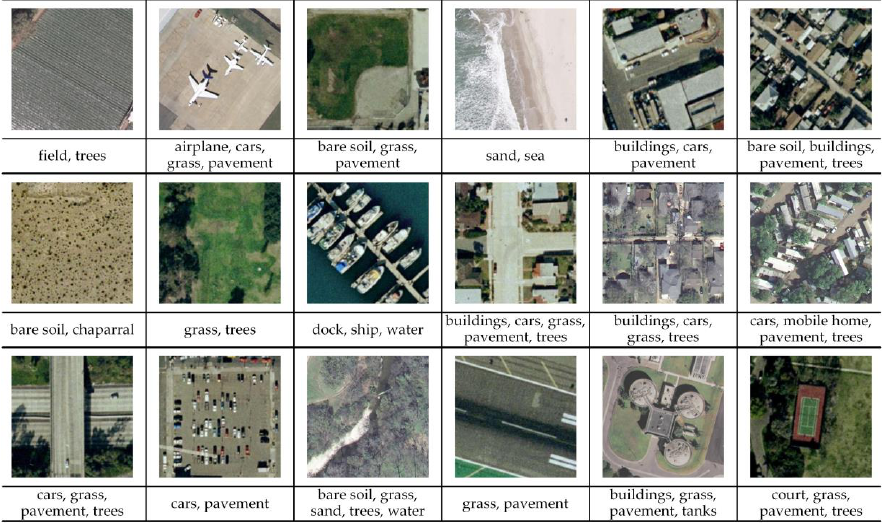
Figure 2. Samples in the UCM multi-label dataset.